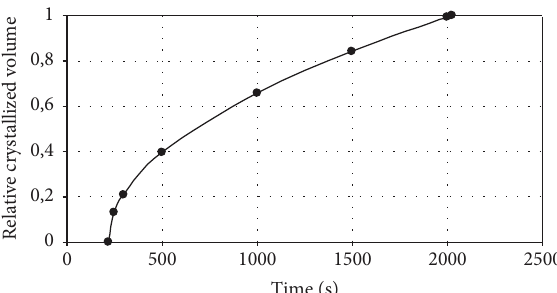
Figure 3: Dynamics of volume growth of the crystallized layer of the cast part in the process of its crystallization.